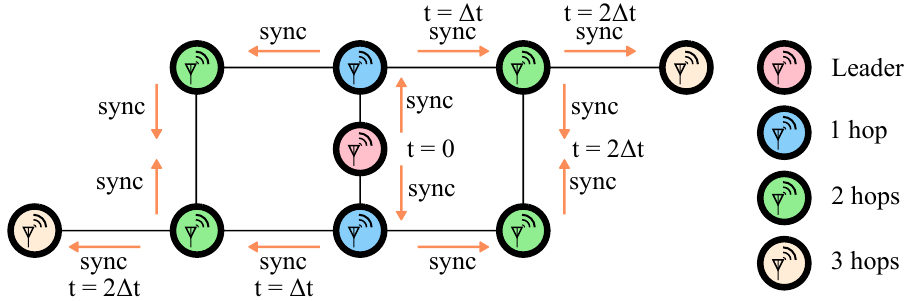
Figure 1. Synchronization packet (sync) propagating through the network starting from the leader node. Colors highlight hops away from the leader. In this work, a 64-bit binary phase-shift keying (BPSK)-encoded Kasami sequence is used.